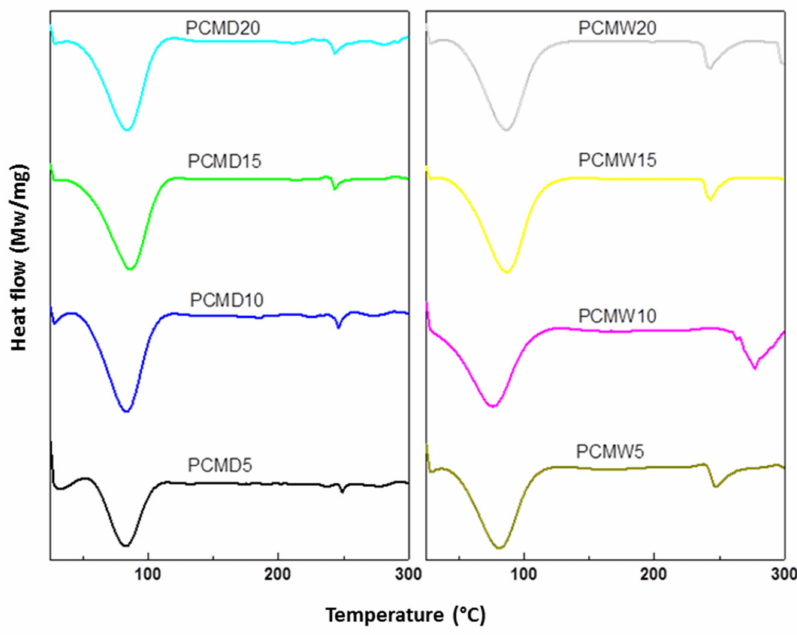
Figure 7. Normalized differential scanning calorimetry (DSC) curves for PCM